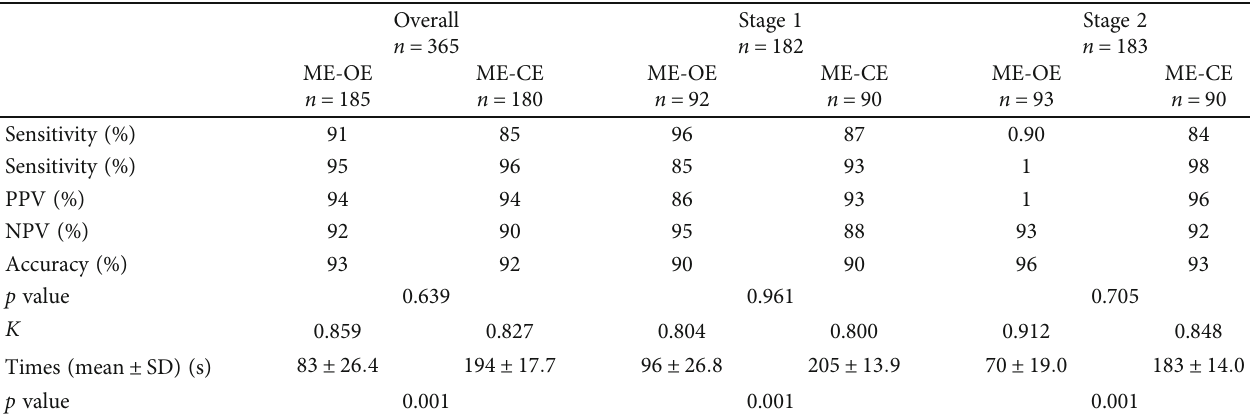
Table 4: Diagnostic accuracy and time in two